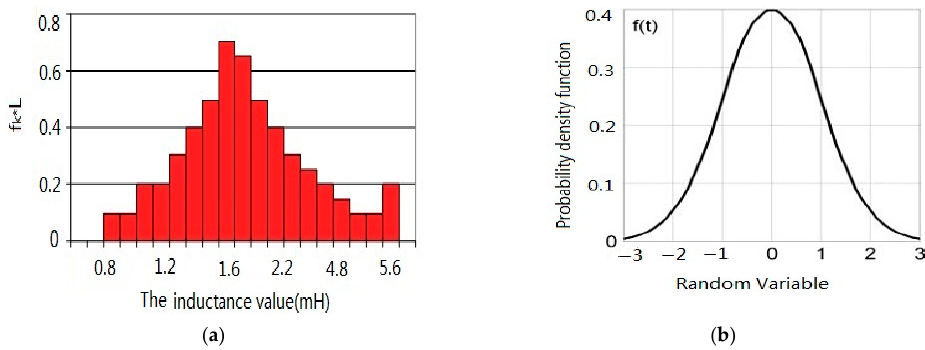
Figure 3. The characteristics of ( a ) inductance changed with the currents and ( b ) permeability of the iron magnetic material under different temperatures.